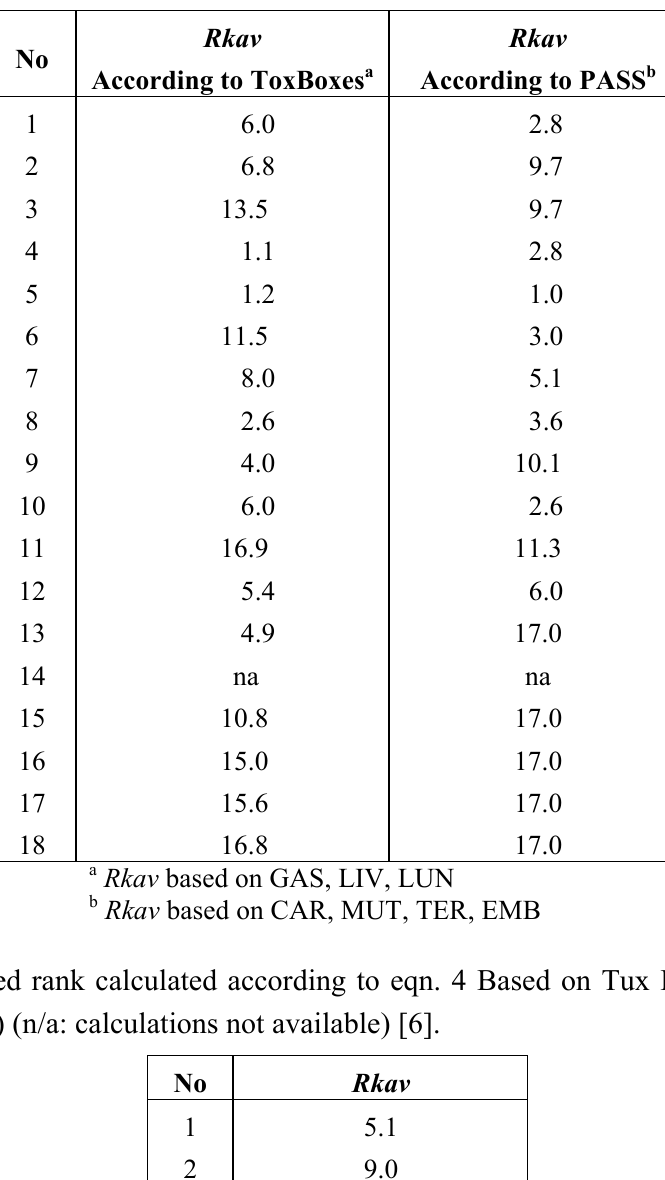
Table 7 . Averaged rank calculated according to eqn. 4 (na: calculations not available) [6].